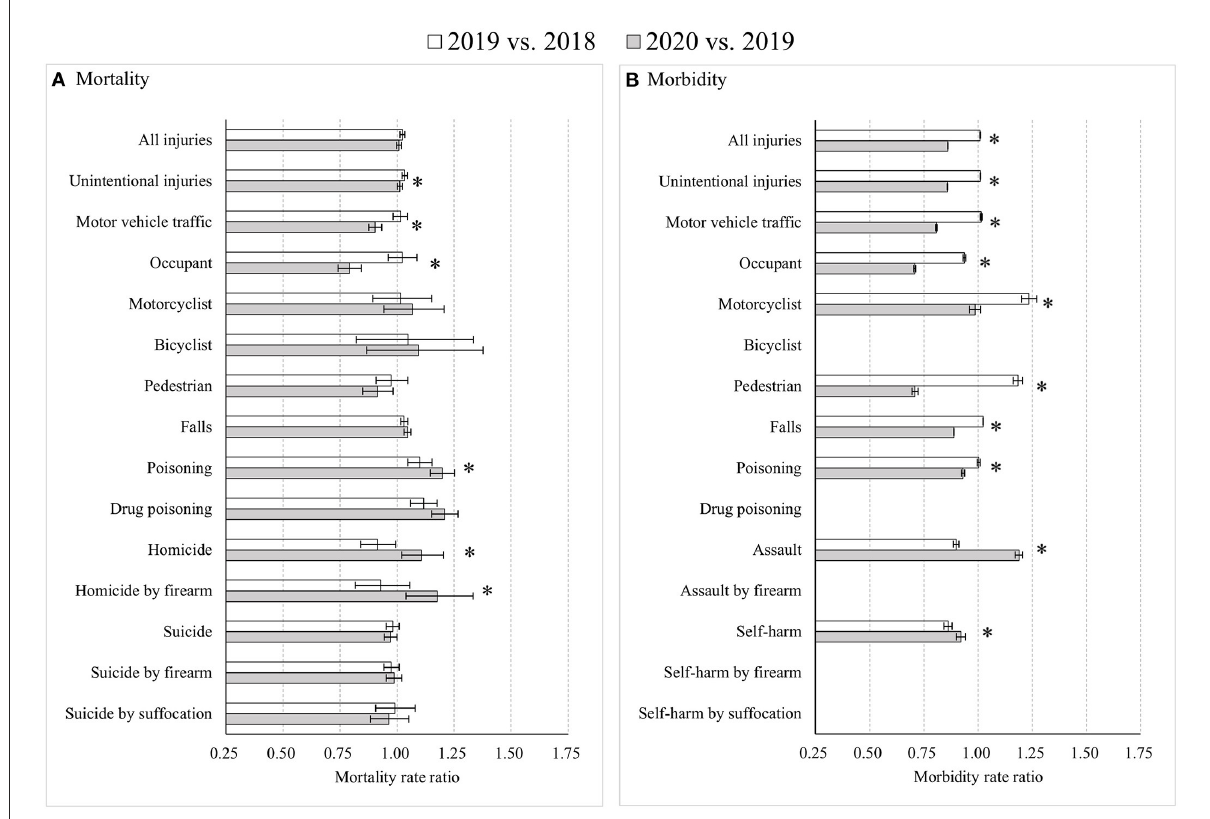
FIGURE5 Age-standardized injury mortality/morbidity rate ratios among Americans aged 65 years and older, 2019 vs. 2018 and 2020 vs. 2019. (A) Mortality; (B) Morbidity. Results were omitted for categories having unstable injury morbidity rates (due to the computation based on cases < 20, the national estimates < 1,200, the coefficient of variation > 30%, or the tool not involving details regarding mechanism of relevant injury). “*” indicates that the differences of MtRRs or MbRRs between 2020 vs. 2019 and 2019 vs. 2018 were statistically